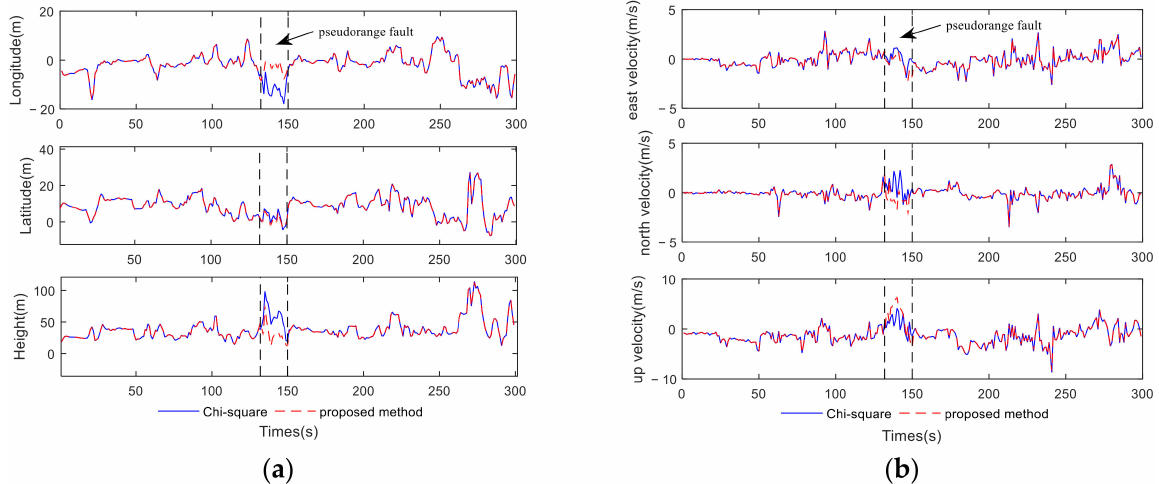
Figure 13. The fusion states errors obtained by the dataset UrbanNav-HK 2020: ( a ) position errors; ( b ) velocity errors.